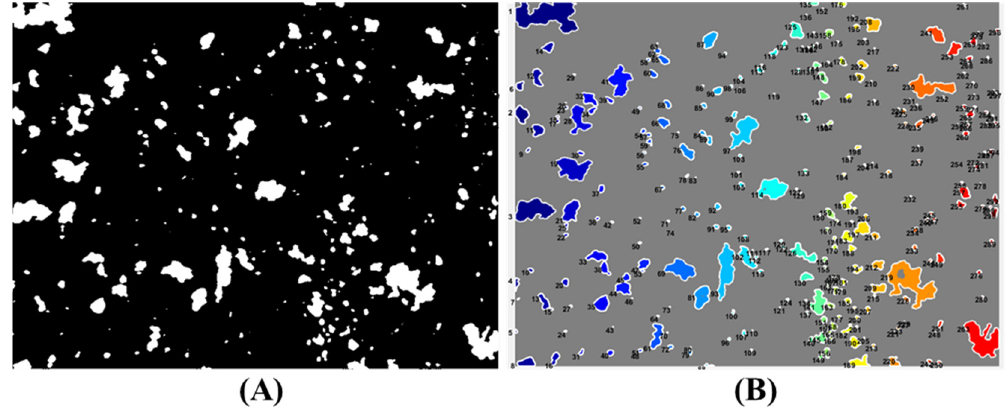
Figure 1. Sample APB1: binary image ( A ) and labelled domains (i.e., objects) ( B ) whose morphological and morphometric attributes were computed.